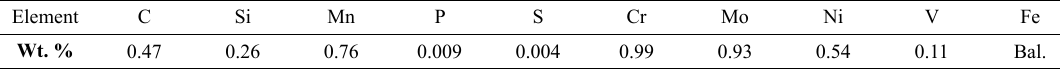
Table 1. Chemical composition of Cr MoV steel (Wt. %).